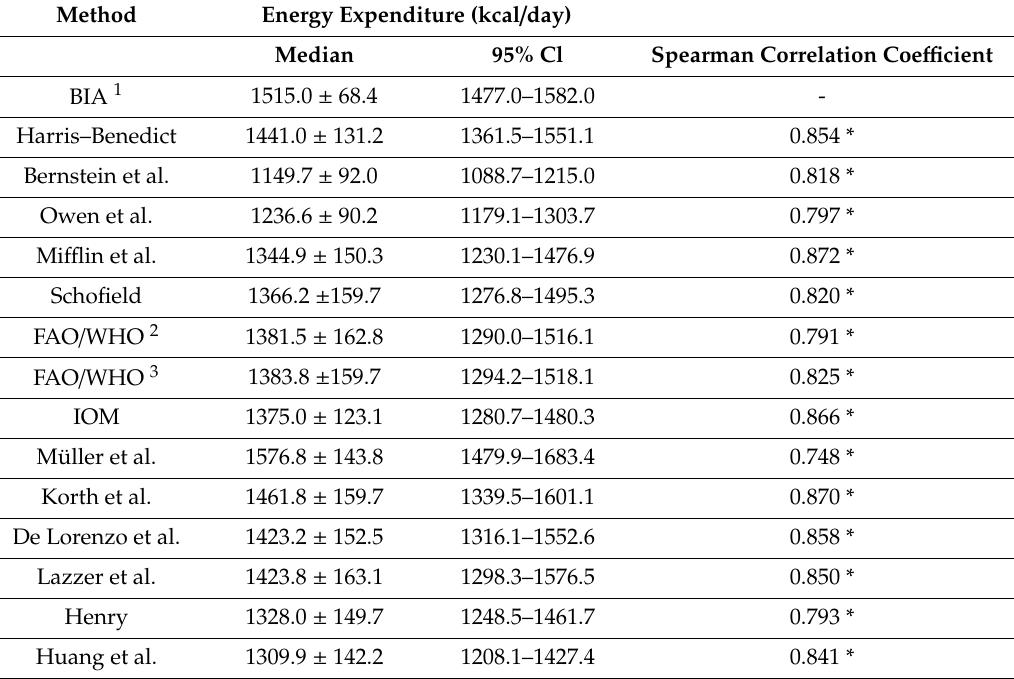
Table 3. Characterization of the eREE and pREE.